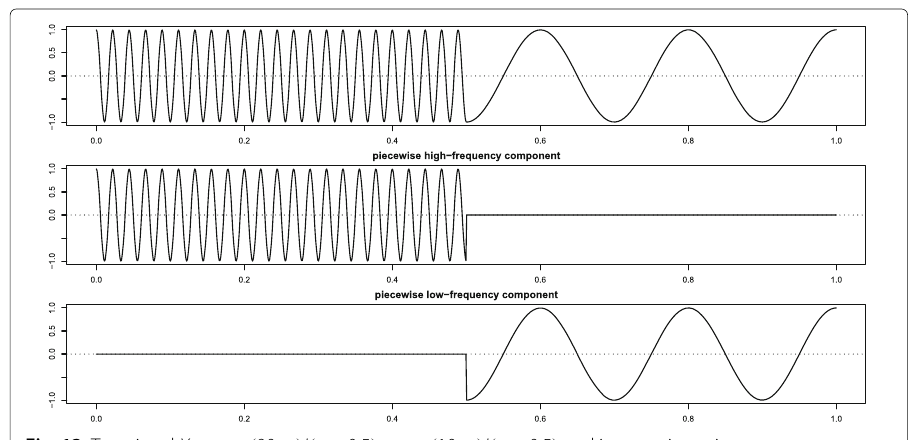
Fig. 13 Test signal X t = cos ( 90 π t ) I ( t ≤ 0.5 ) + cos ( 10 π t ) I ( t > 0.5 ) and its two piecewise components